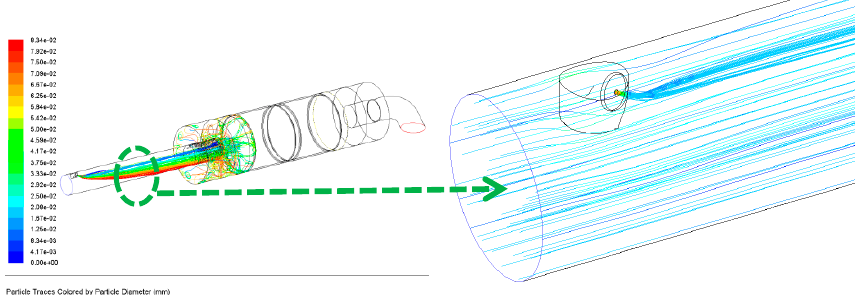
Figure 4. Particle traces and flow line distribution of the initial nozzle (Operation Points 1).